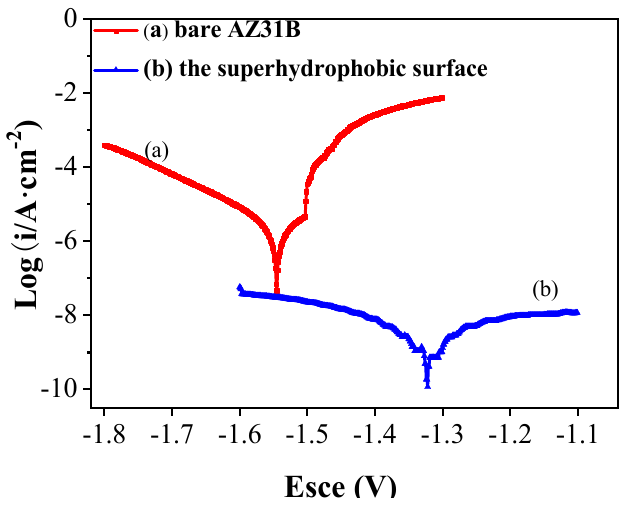
Figure 9. Polarization curve of AZ31B Mg alloy surface: ( a ) pre–treated magnesium alloy, ( b ) the PVDF/PFOTESSiO 2 super-hydrophobic surface on Mg alloy.